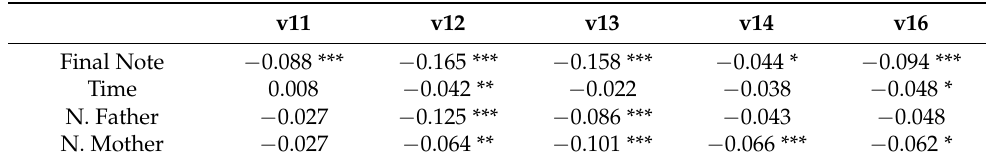
Table 7. Goodman and Kruskal gamma test. Perception of the degree of difficulty in assimilating the competences. v11